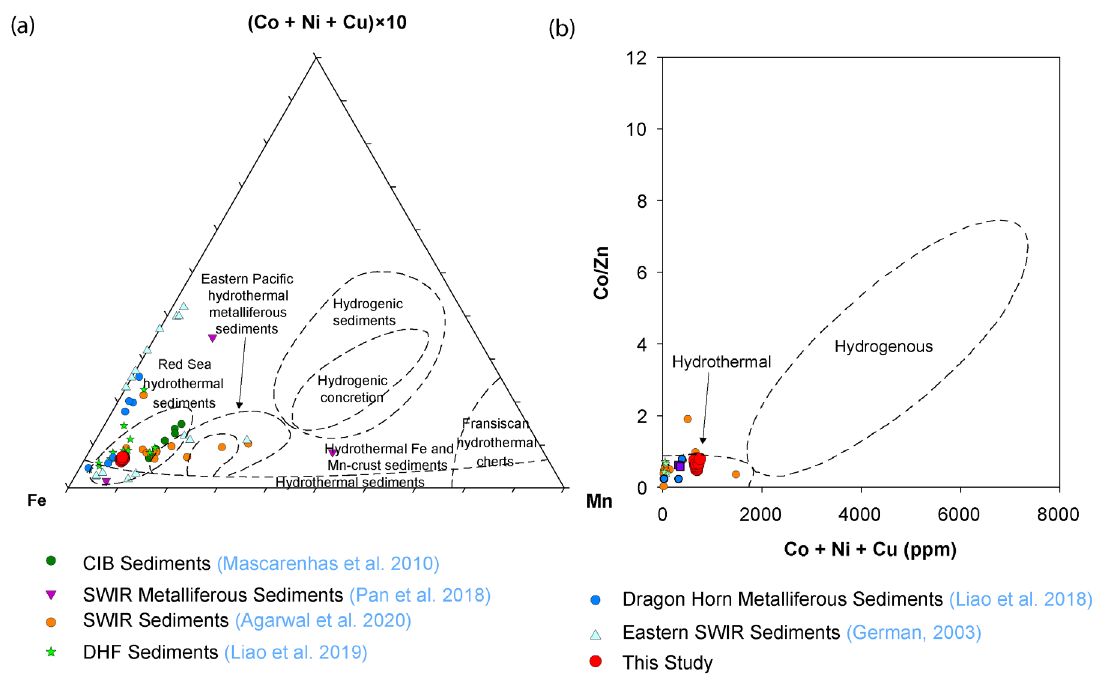
Figure 9. ( a ) Fe-Mn-(Co + Ni + Cu)x10) ternary (Modified from [46]). ( b ) Scatter plot of Co/Zn ratio versus Cu + Ni + Co content of the sediment core (Modified from [39]). Data points are taken from different sources, Metalliferous Sediments from Central Indian Ocean (CIB) [39], Metalliferous Sediments, SWIR [13,20], Duanqiao-1 hydrothermal field Sediments [19], Dragon Horn Metalliferous Sediments [18], Eastern SWIR Sediments [15].